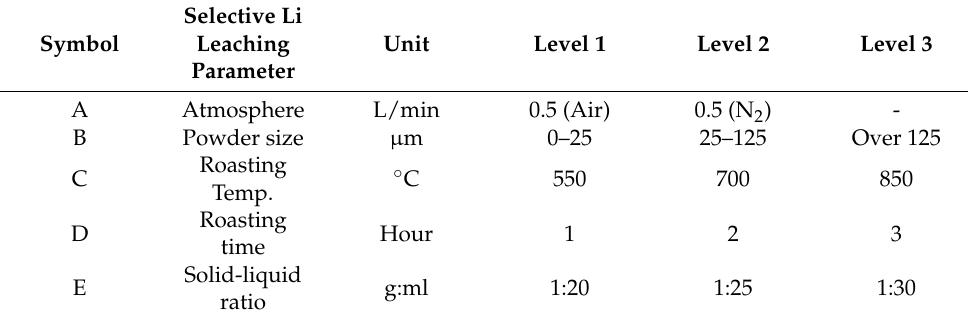
Table 1. Selective lithium leaching parameters and their